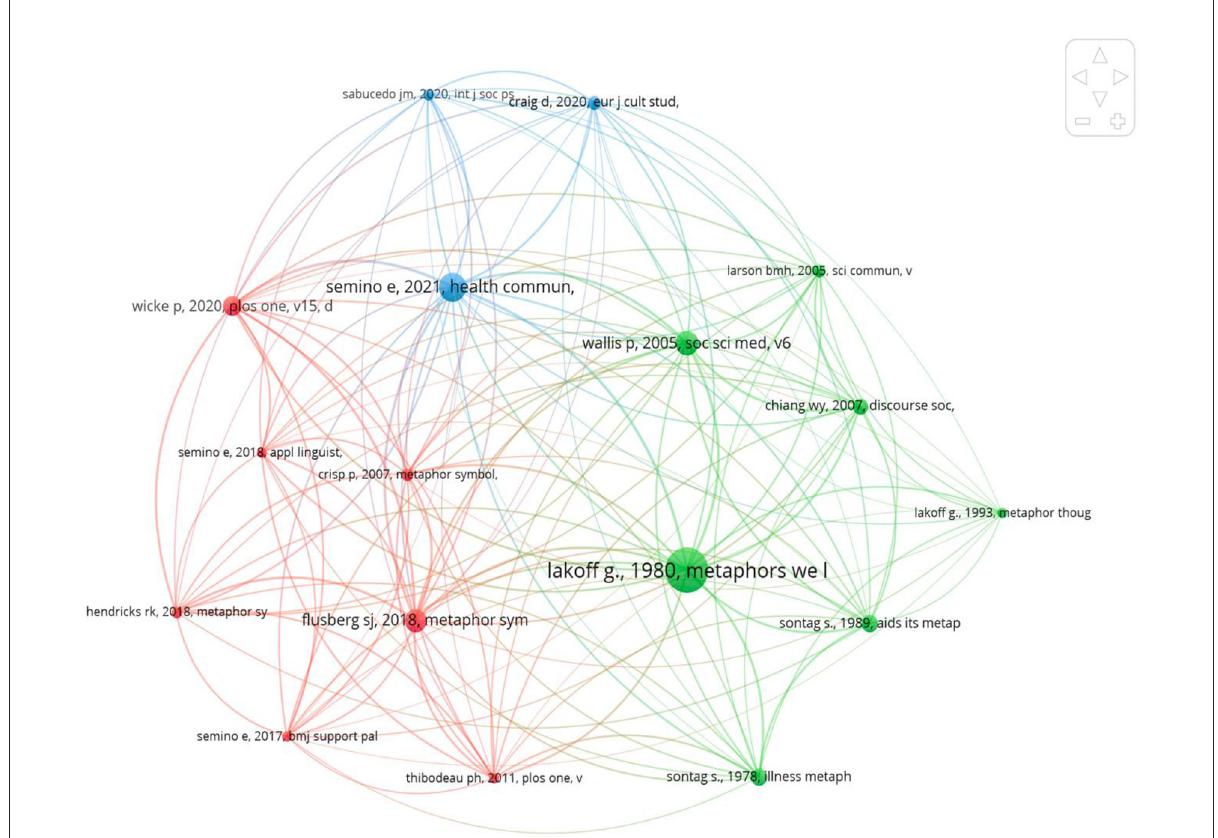
FIGURE4 Visualization of the most frequent co-citers and co-citing references network.